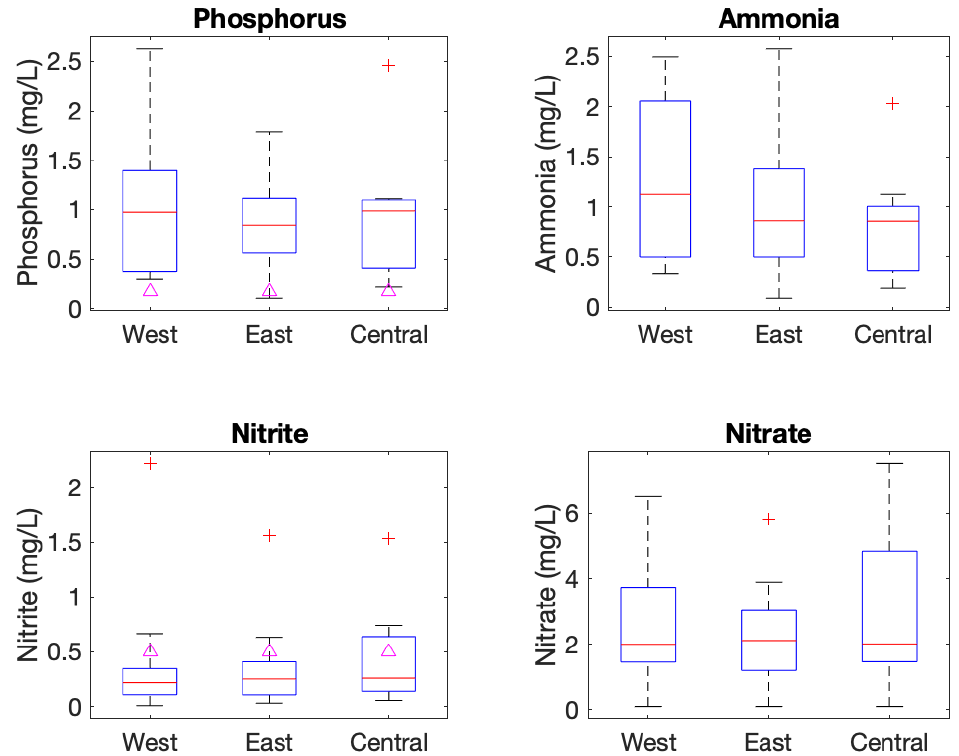
Figure A1. Wet weather water quality—dissolved-nutrient boxplots. Red plus signs indicate outliers and triangles represent Colorado Department of Public Health and Environment (CDPHE) in-stream standards, where relevant.